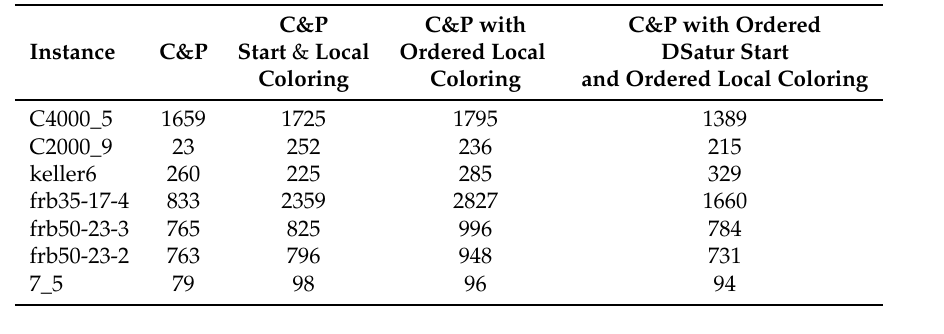
Table 3. Evaluation of the mean number of tabu search iterations per second for four of the algorithms appearing in Tables 1 and 2. These replace exact search and pseudoexact search in Hybrid Tabu Search (HTS). The best exact algorithm should maximize the number of tabu search iterations per second during an extended run.